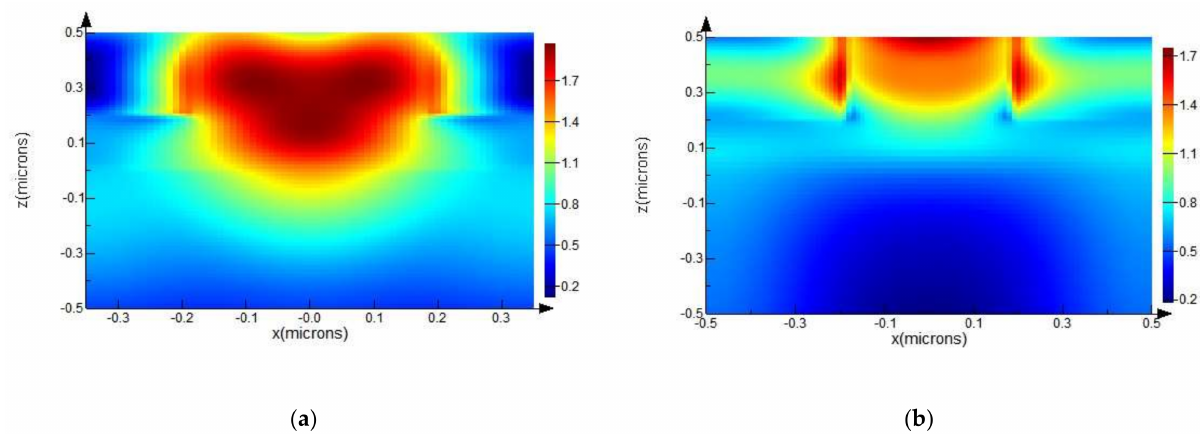
Figure 8. Spatial distribution of electric field intensity at 700 nm wavelength, calculated from an FDTD simulation, for ZnO NRs with radii of 200 nm ( a ) with Ag NPs with radii of 20 nm; and ( b ) without Ag